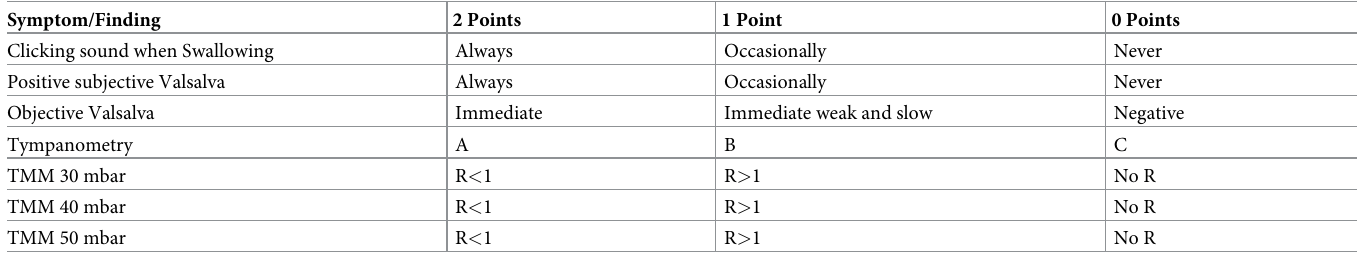
Table 1. Parameters for the ETS-7